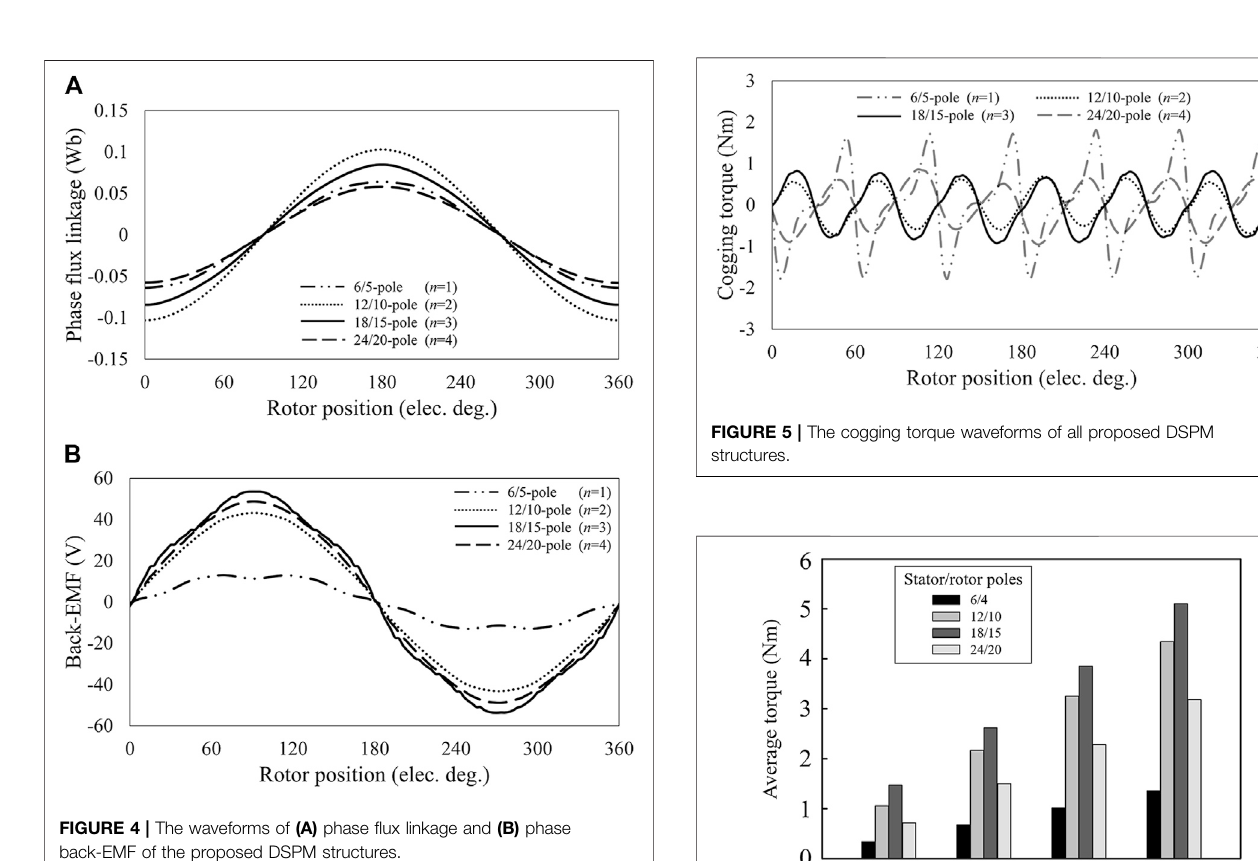
FIGURE 3 | Magnetic fi eld distribution of all proposed DSPM structures with (A) 6/5, (B) conventional 12/10, (C) 18/15, and (D) 24/20 poles.